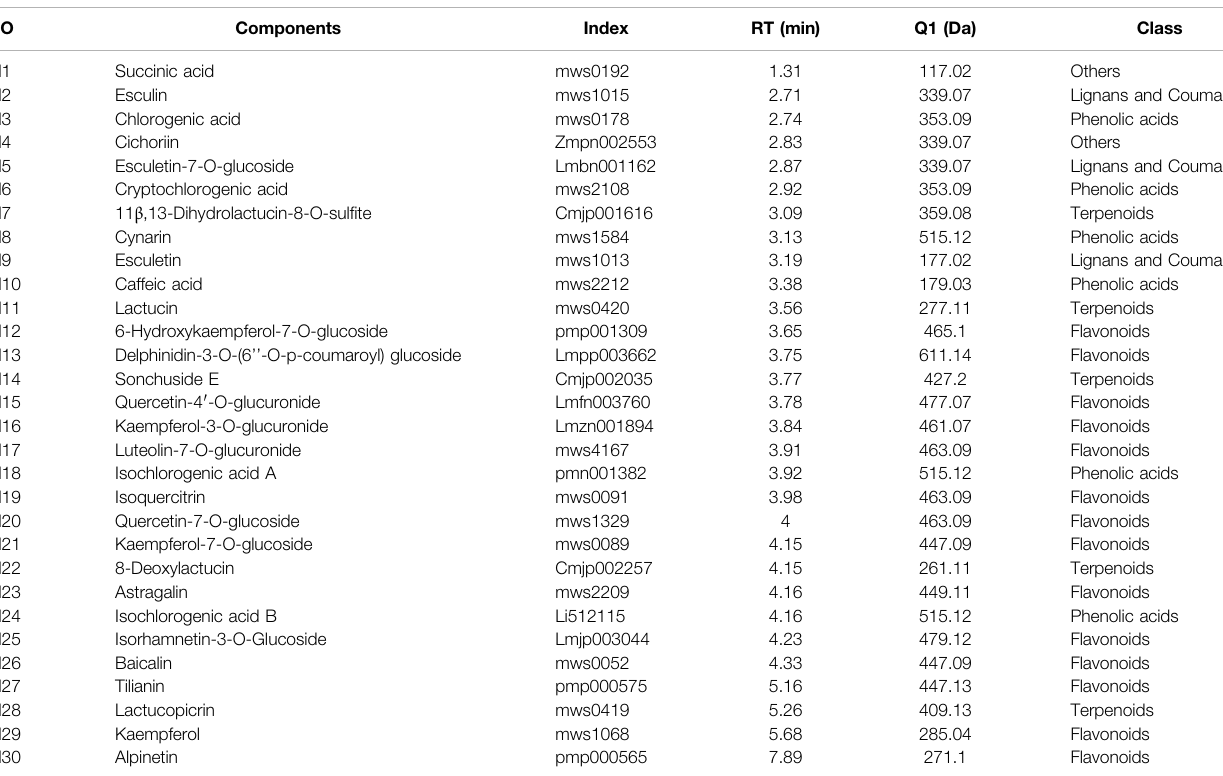
TABLE 3 | UPLC-MS/MS representative information of the 30 compounds.